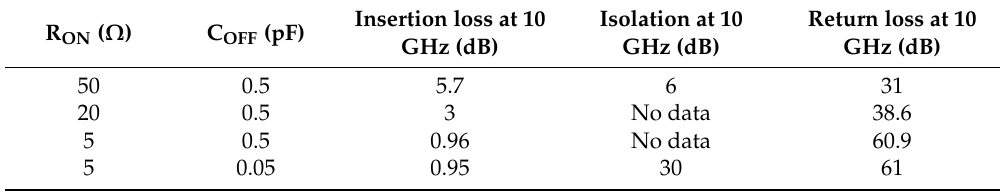
Table 2. The RF performance parameters of the device.